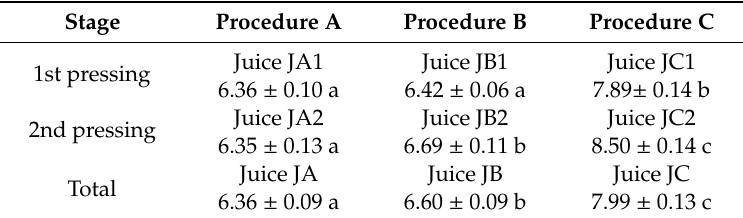
Table 2. Extract content ( ◦ Bx) of juice from celeriac root chips according to the selected procedure and pressing stage. Abbreviations, as in Figure